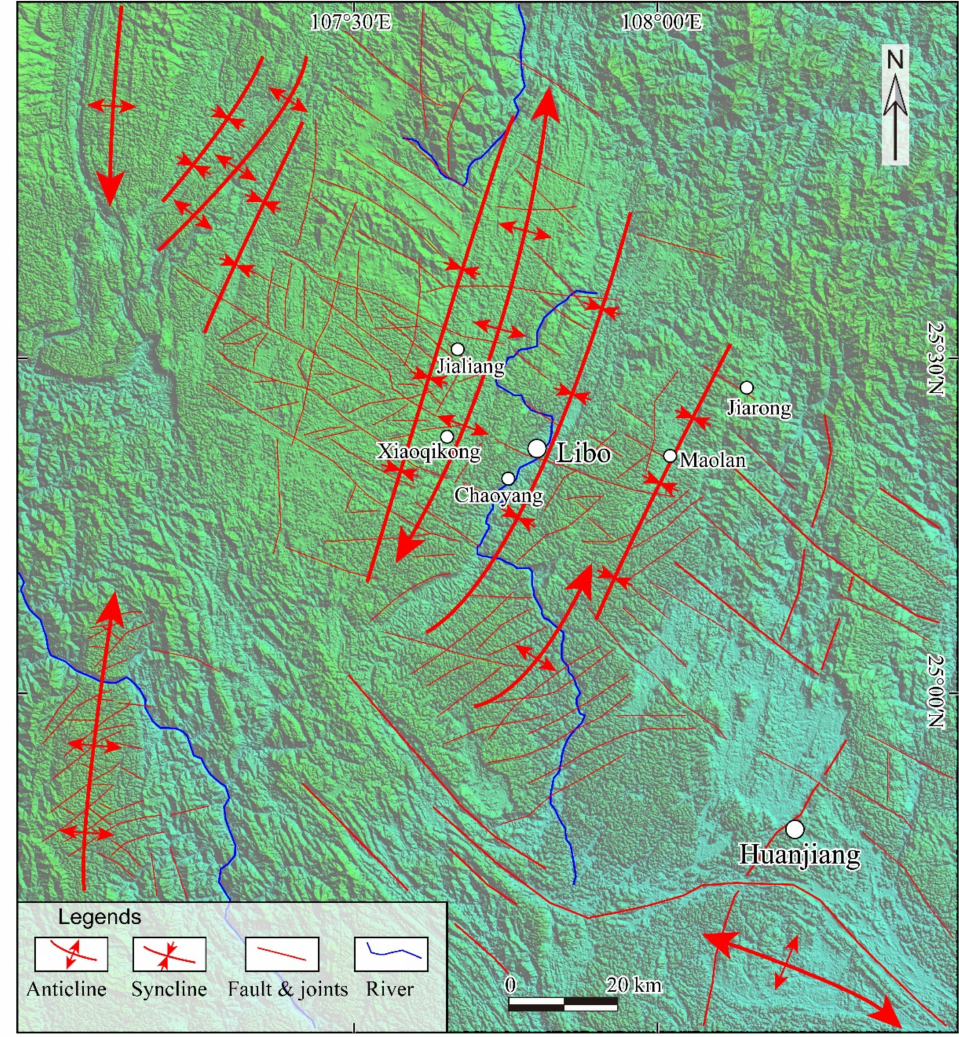
Figure 2. Structural features of the Libo area interpreted from DEM